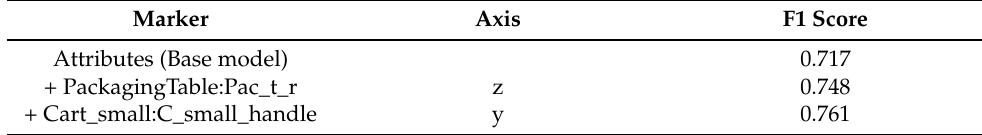
Table 8. Greedy feature selection results (RF, raw